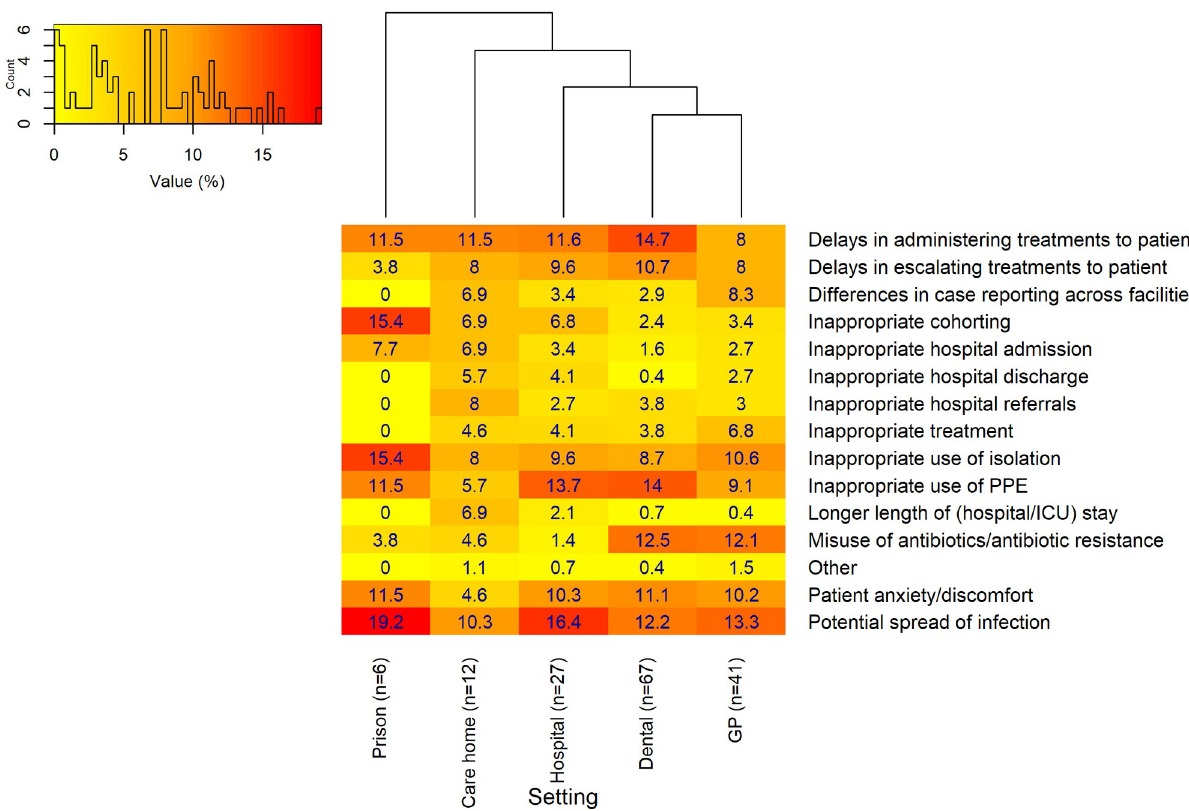
Fig 3. Perceived consequences of no COVID-19 tests being available in each setting. Primary and secondary dental settings were merged, in addition to care homes with and without nursing. The ‘Hospital-at-home’ (n = 3), hospice (n = 14) and ambulance setting (n = 9) were excluded due to the small number of overall respondents. A hierarchical cluster analysis indicates how similar/dissimilar the perceived consequences of no COVID-19 tests are between settings. The numbers of responses from individual settings for this particular question are displayed on the x axis (n = x). The histogram in the top left of the plot area shows the distribution of values, and provides a key to indicate the specific color shade of different values.